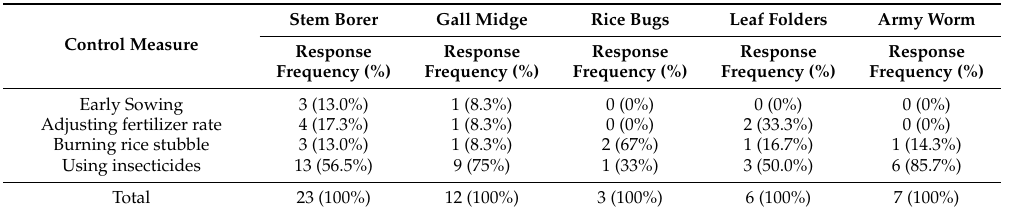
Figure 5. Proportion of farmer respondents who could correctly identify either the major insect pests of rice or their symptoms. Table 3. Proportion of farmer respondents who use different control measures for the 5 major insect-pests of rice.